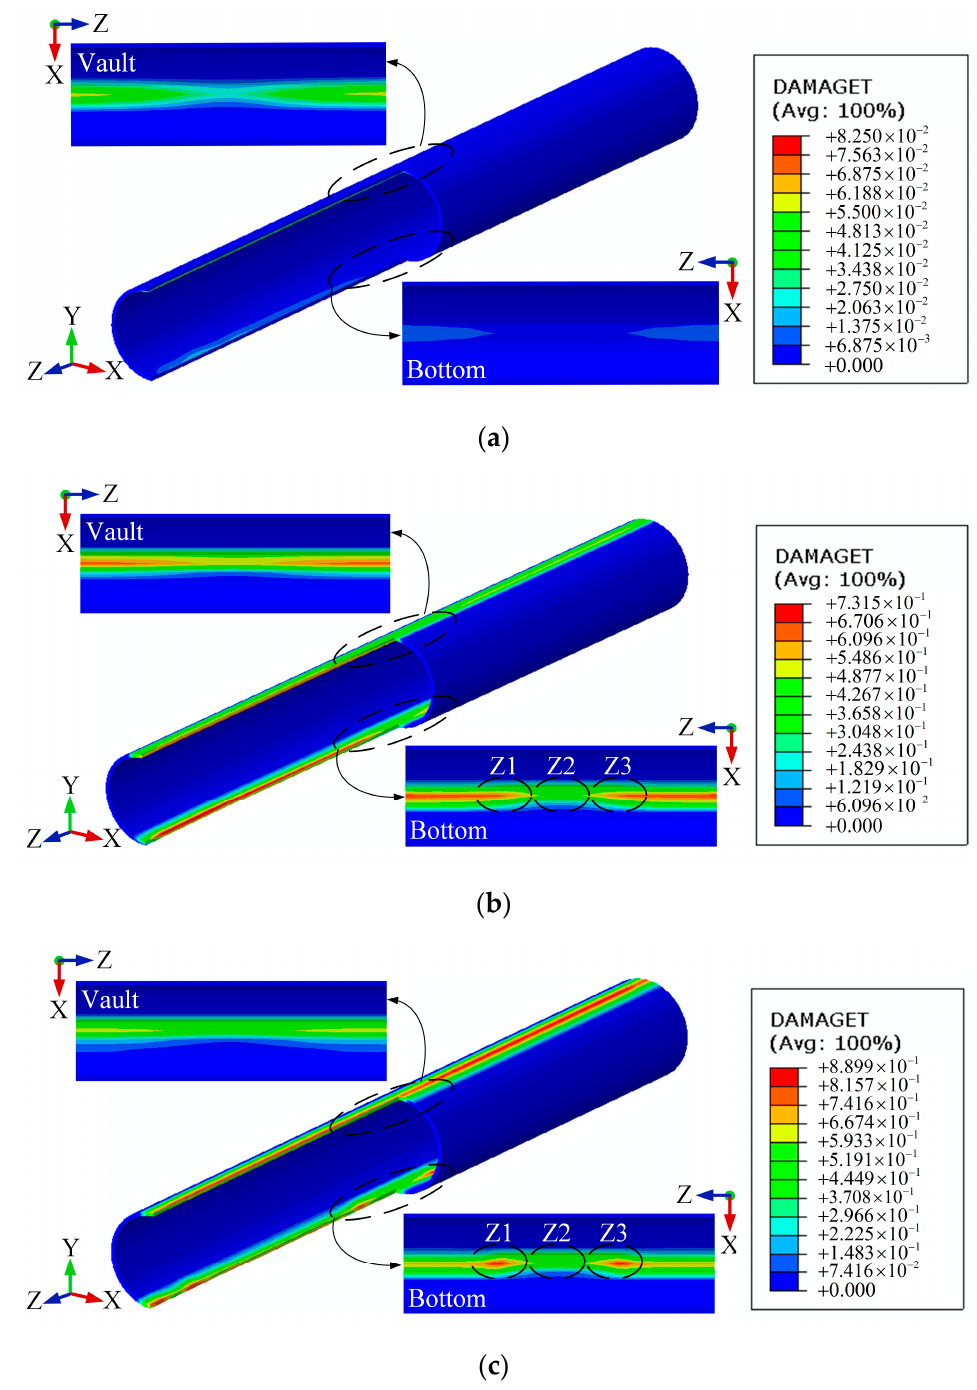
Figure 13. Tunnel’s damage diagram and details of the vault and bottom at different times: ( a ) tunnel’s damage at 2 s, ( b ) tunnel’s damage at 3.14 s, and ( c ) tunnel’s damage at 12 s.